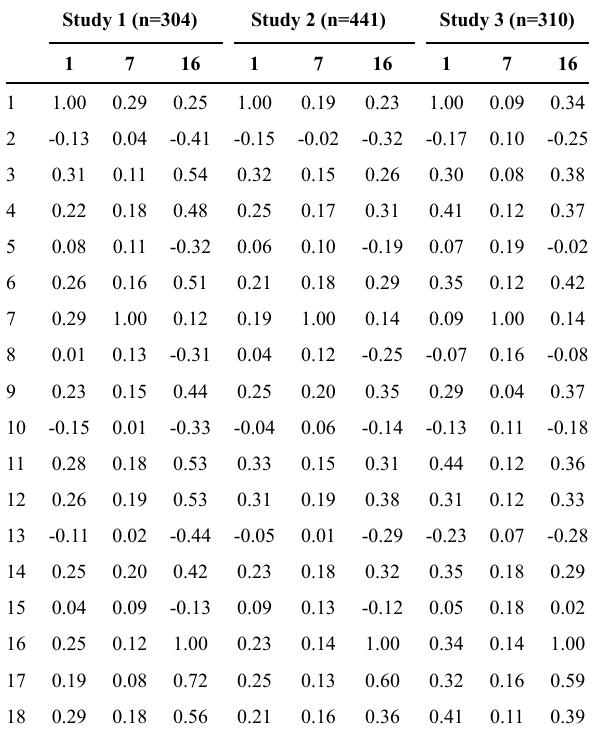
Table 4 - Correlation between the items of the introjected regulation dimension in the three studies. Study 1